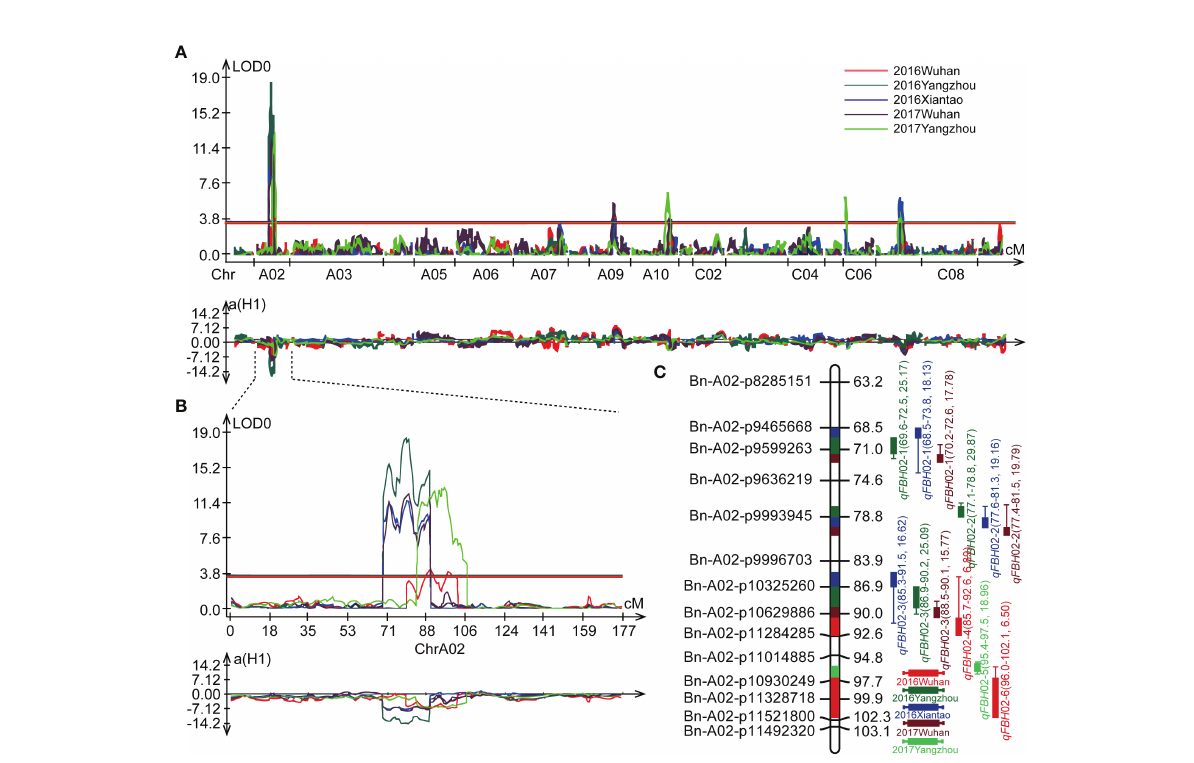
FIGURE 3 Quantitative trait loci (QTL) identi fi cation for FBH in fi ve environments. (A) QTL distribution on the whole genome; diverse colors represent the QTL identi fi ed in different environments. (B) Localization of the identi fi ed QTLs on linkage group A02 in different environments. (C) Genetic markers and QTL localizations on linkage group